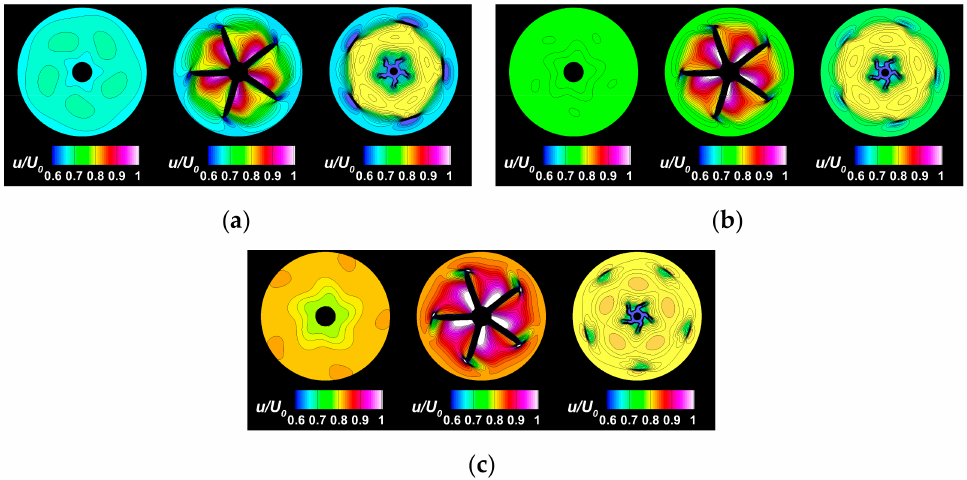
Figure 4. Instantaneous non-dimensional axial velocity fields computed at 0.5 R upstream of the propeller (left), in the propeller plane (middle) and at 0.5 R downstream of the propeller (right): ( a ) J = 0.5, ( b ) J = 0.7, ( c ) J =